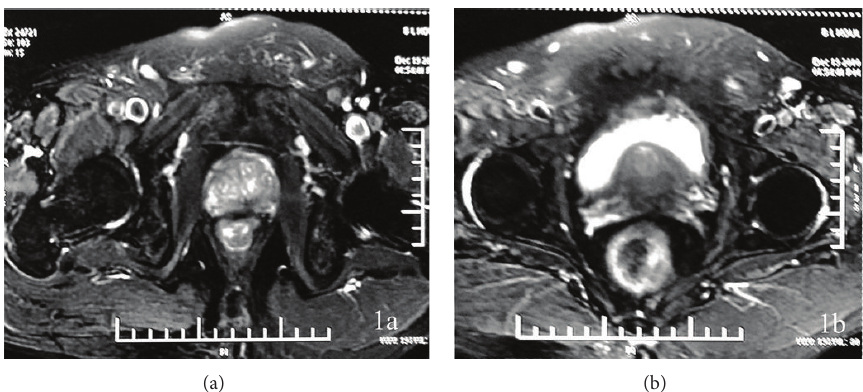
Figure 1: MRI showed ill-defined low intensity signal in peripheral zone of prostate and adjacent portion of bilateral seminal vesicles.